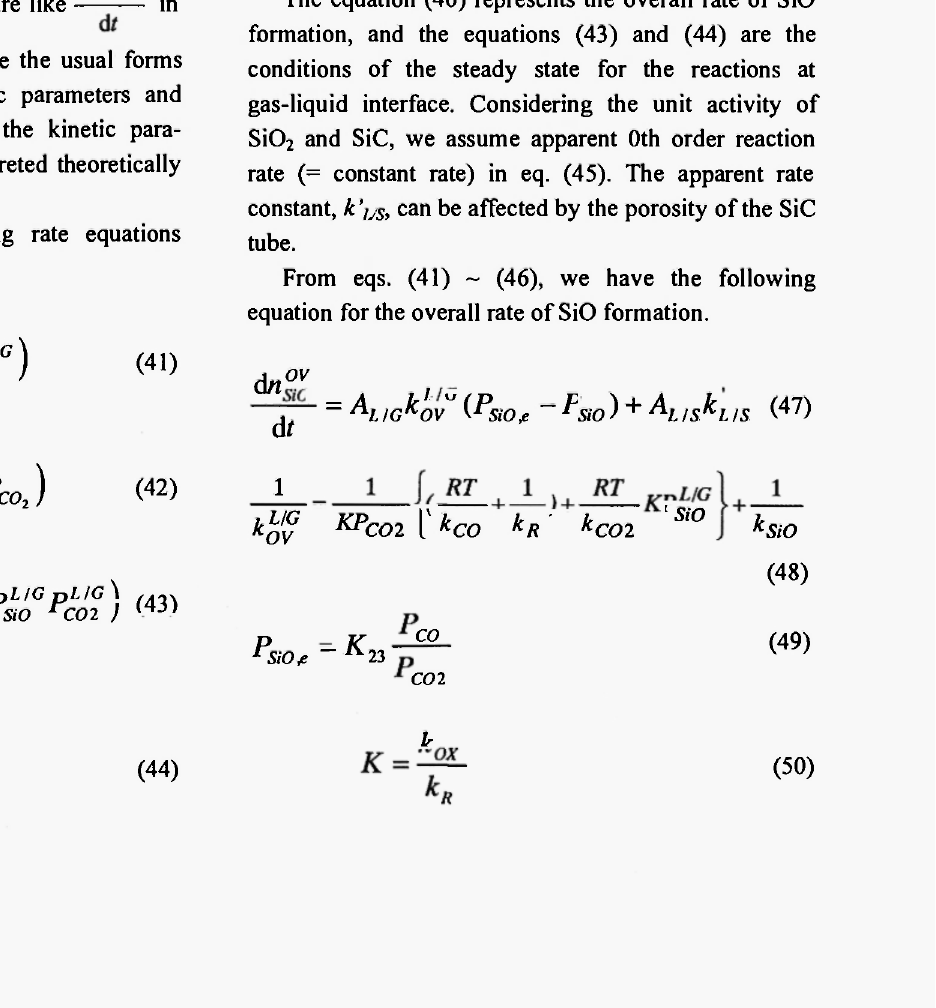
Figure 12. Arrheniusian behaviors are the usual forms of the relations between the kinetic parameters and temperature. The relations between the kinetic para- meters and temperature can be interpreted theoretically as follows. Here, we consider the following rate equations representing the SiO formation